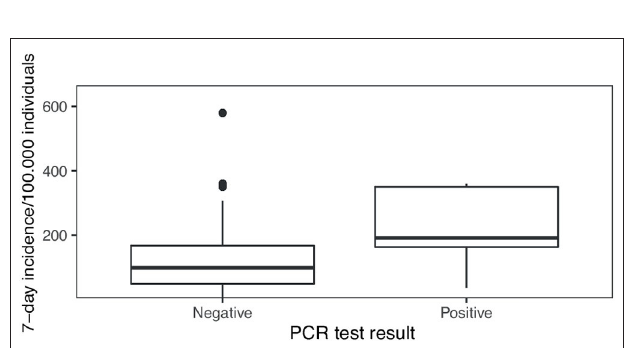
FIGURE 5 | PCR test results in the context of local 7-day incidence numbers: The local 7-day incidence per 100,000 individuals differs between days when negative and positive PCR test results were obtained in our study ( p < 0.0005).